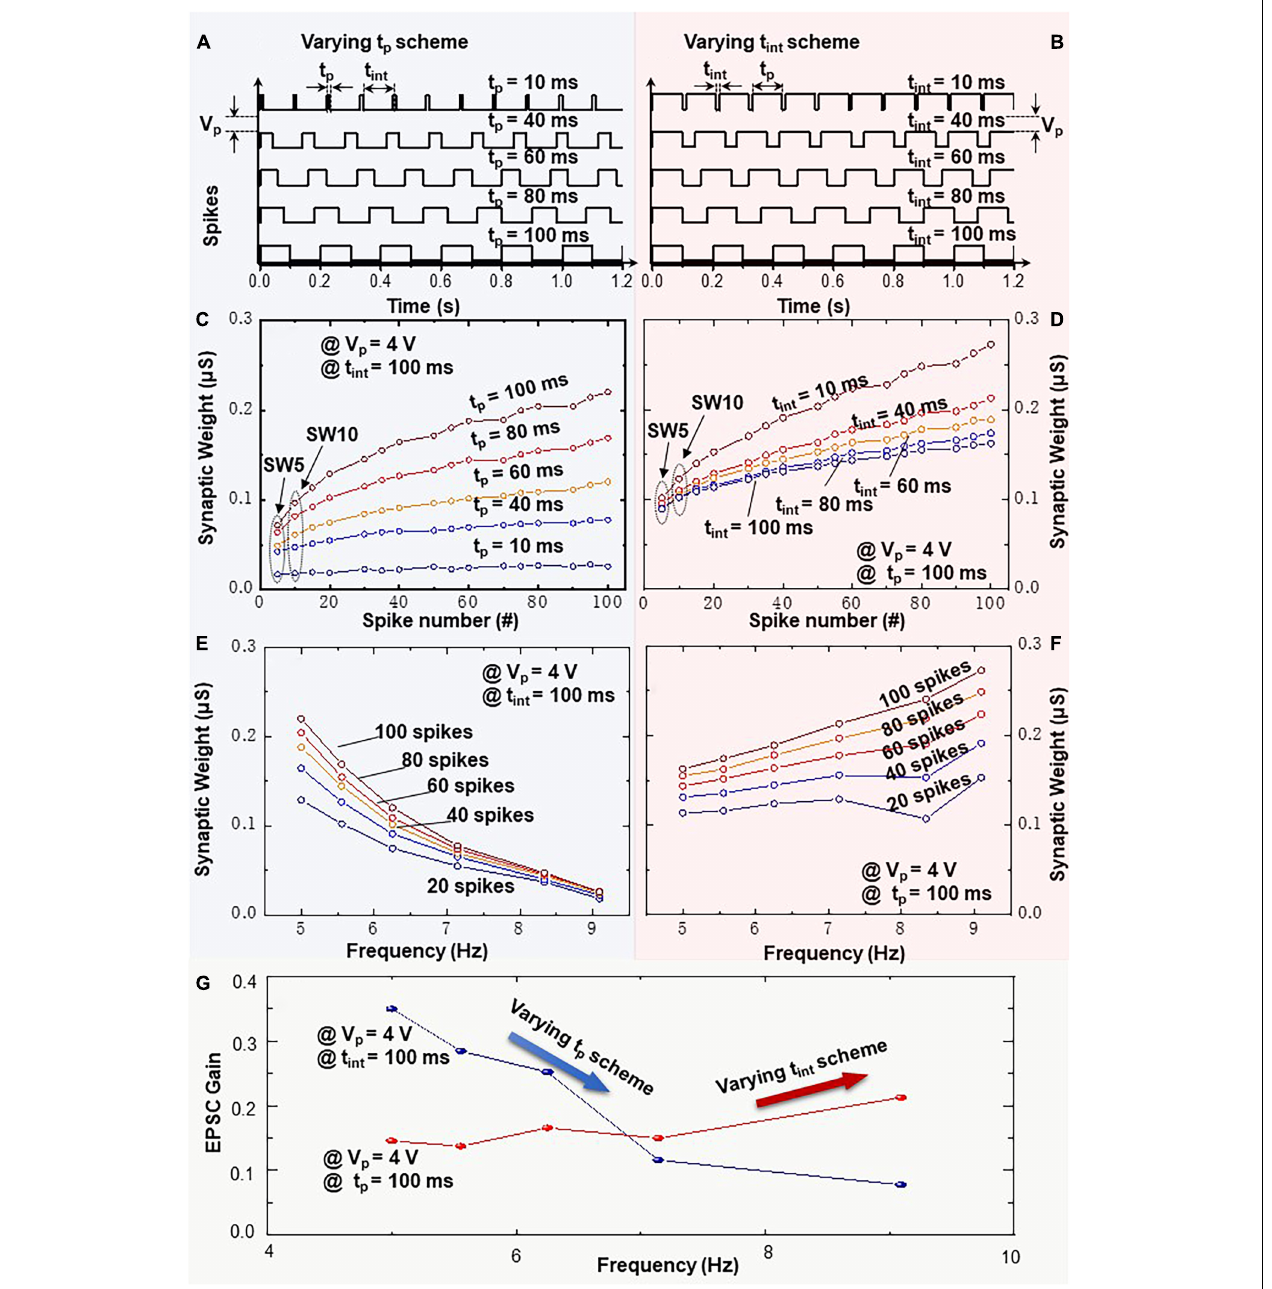
FIGURE 6 | Frequency-dependent plasticity learning rule executed by spike trains with variation of pulse width t p or time interval t int = 10, 40, 60, 80, and 100 ms (varying t p scheme and varying t int scheme). Schematic diagrams of spike trains with amplitude of V p = 4V and variation of panels (A) t p or (B) t int . Recorded synaptic weights as a function of spike number upon 100 consecutive spikes with (C) t p or (D) t int variation. EPSC response triggered by spike trains (V p = 4V) and different frequencies with (E) t p or (F) t int variation. (G) Frequency-dependent EPSC gains at V p = 4V with t p or t int variation.